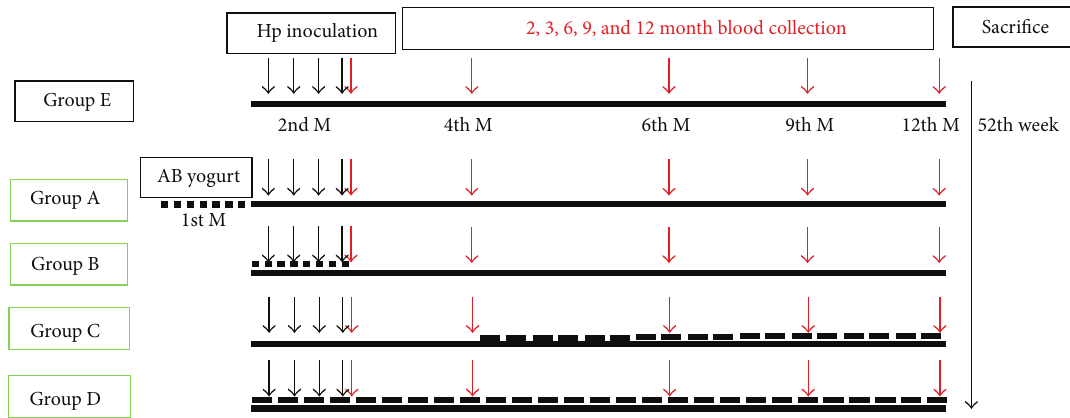
Figure 1: The timing of yogurt given: Gr. A: the yogurt was fed daily in 1st to 4th week. Gr. B: the yogurt was fed from 5th to 8th week. Gr. C: the yogurt was fed since 17th week to the point of sacrifice. Gr. D: the yogurt was fed since 5th week to the point of sacrifice. Gr. E: the yogurt was not given. The animals were sacrificed on the 52th experimental